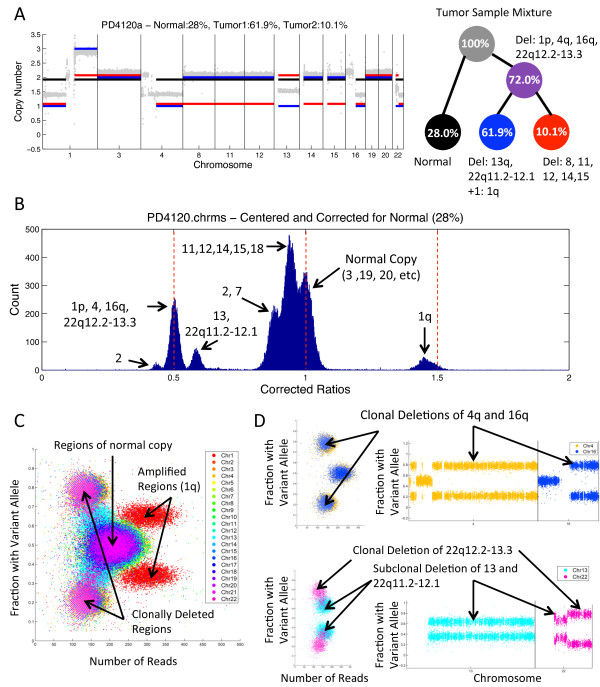
Analysis of the 188× coverage breast tumor PD4120a. (A) (Left) Read depth ratios (gray) and the copy number aberrations inferred by our algorithm when n = 3 including the normal population (black), dominant (clonal) tumor population (blue) and subclonal tumor population (red). (Right) A reconstruction of the tumor mixture with the inferred aberrations and estimated fraction of cells in each subpopulation. (B) Read depth ratios in 50 kb intervals after centering so chromosome 3 has a mean of 1 and correcting for 28% normal admixture using a simple linear scaling. (C) Virtual SNP array results showing distinct clusters of regions according to the number of reads containing each SNP and fraction of reads supporting the variant allele. (D) Virtual SNP array data comparing variant allele fractions and read counts for chromosomes 4 and 16. This data demonstrate that both chromosomes have undergone the same type of copy number aberration, which we predicted to be a clonal deletion in 72% of cells in the sample. (E) Virtual SNP array data for chromosomes 13 and 22. Chromosome 22q11.2-12.1 and chromosome 13 appear to be affected by the same type of aberration, which we predicted to be a subclonal deletion in 61.9% of cells in the sample. In contrast, 22q12.2-13.3 is different, and the data are consistent with a clonal deletion. See Additional file 1, Figure S13 for further details.